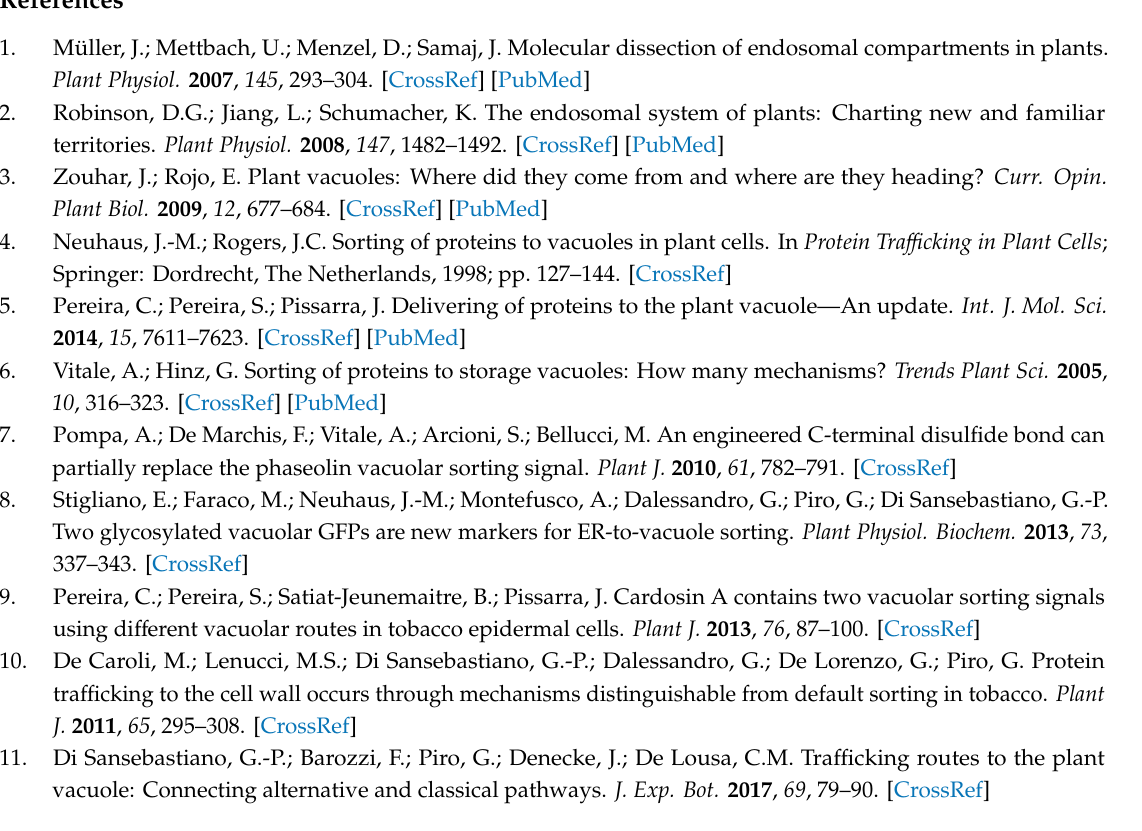
Figure S1: Subcellular localization of cardosins A and B and PSI-swapped version with the C-terminal vacuolar sorting signal present. Figure S2: Dissection of SP::PSI-A::mCh and SP::PSI-B::mCh tra ffi cking pathways in N. tabacum leaves and protoplasts. Figure S3: Blocking SP::PSI-1::mCh and SP::PSI-2::mCh with Rabd2a N121I